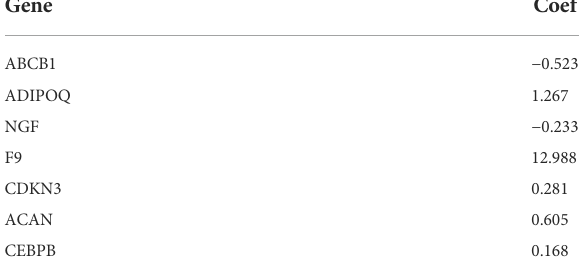
TABLE 1 Independent prognostic genes and coef fi cients.